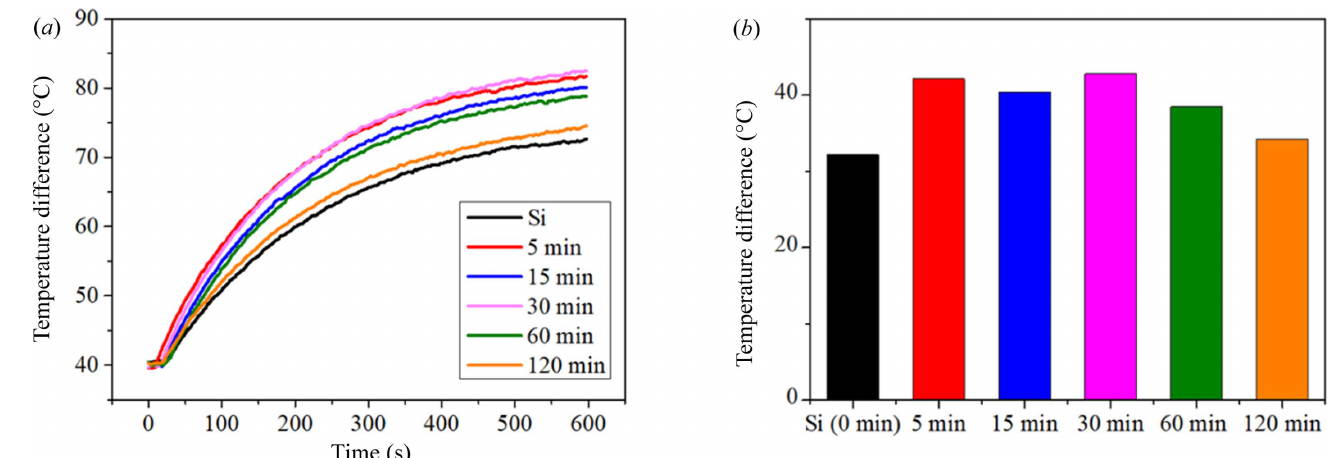
Figure 6 Plasmonic light-to-heat energy conversion in water-heating experiments with various samples. ( a ) Temperature increases from 40 (cid:4) C. ( b ) Temperature increases after water-heating